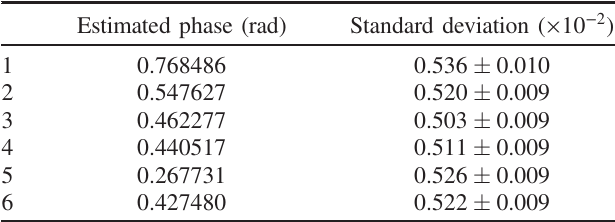
TABLE I. Standard deviation of phase